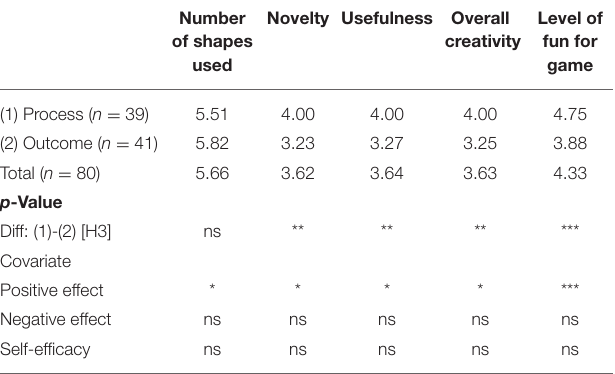
TABLE 2 | Summary of experiment 2.